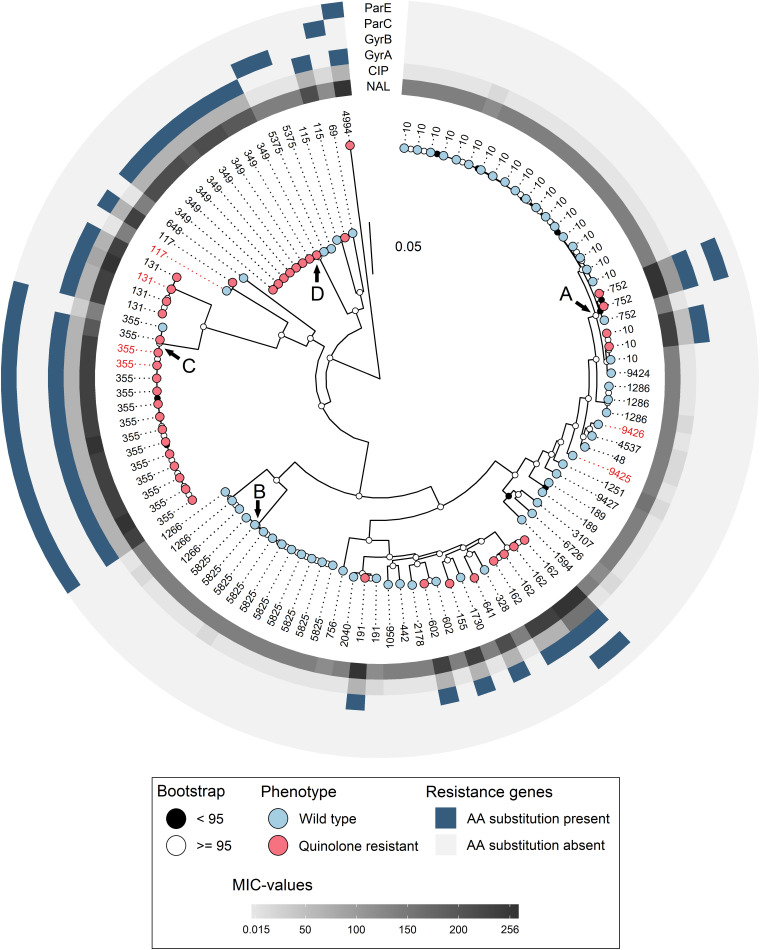
Maximum likelihood SNP tree calculated with IQTree, based on the 2931 core genes identified with Roary. The tree is midpoint rooted for better visualization. Bootstrap values are represented as black (<95) and white (≥ 95) circles on the nodes. Phenotype is represented as blue (wild type) and red (quinolone resistant) on the tip points. Sequence types are denoted as tip labels, red labels represent parent animals. MIC-values for ciprofloxacin (CIP) and nalidixic acid (NAL) are represented as increasing gray color in the innermost circles. Amino acid substitutions in the four genes related to quinolone resistance is denoted as blue in the surrounding circles. Arrows denote clades further investigated. Evolutionary model: GTR + F + ASC + R5.